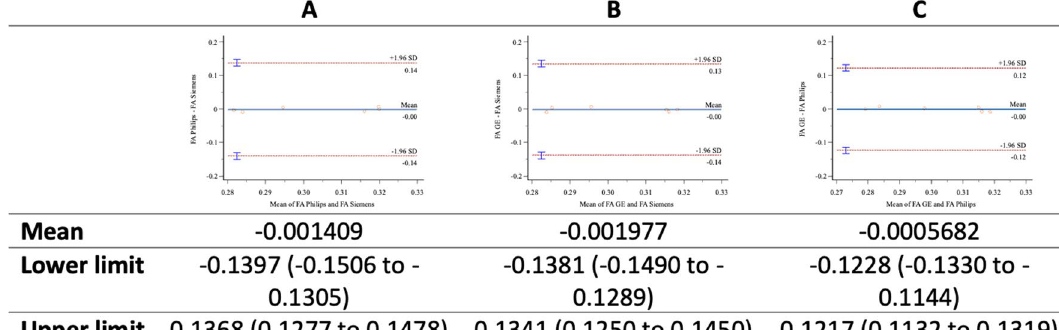
Fig. 4 FA- A : Philips versus Siemens; B : GE versus Siemens; C : GE versus